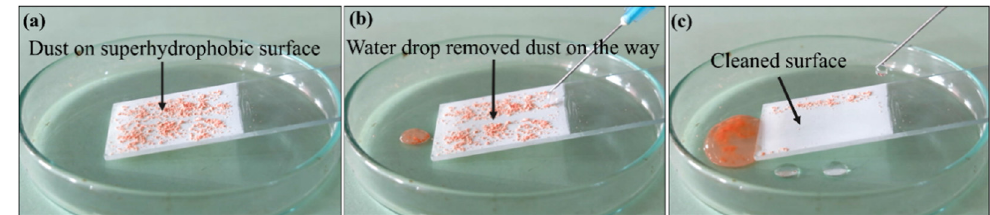
Figure 5. Self-cleaning performance of the prepared superhydrophobic AD-2 coating. ( a ) Dust particles on the superhydrophobic coating, ( b ) water drops carrying the dust particles, and ( c ) the cleaned surface.